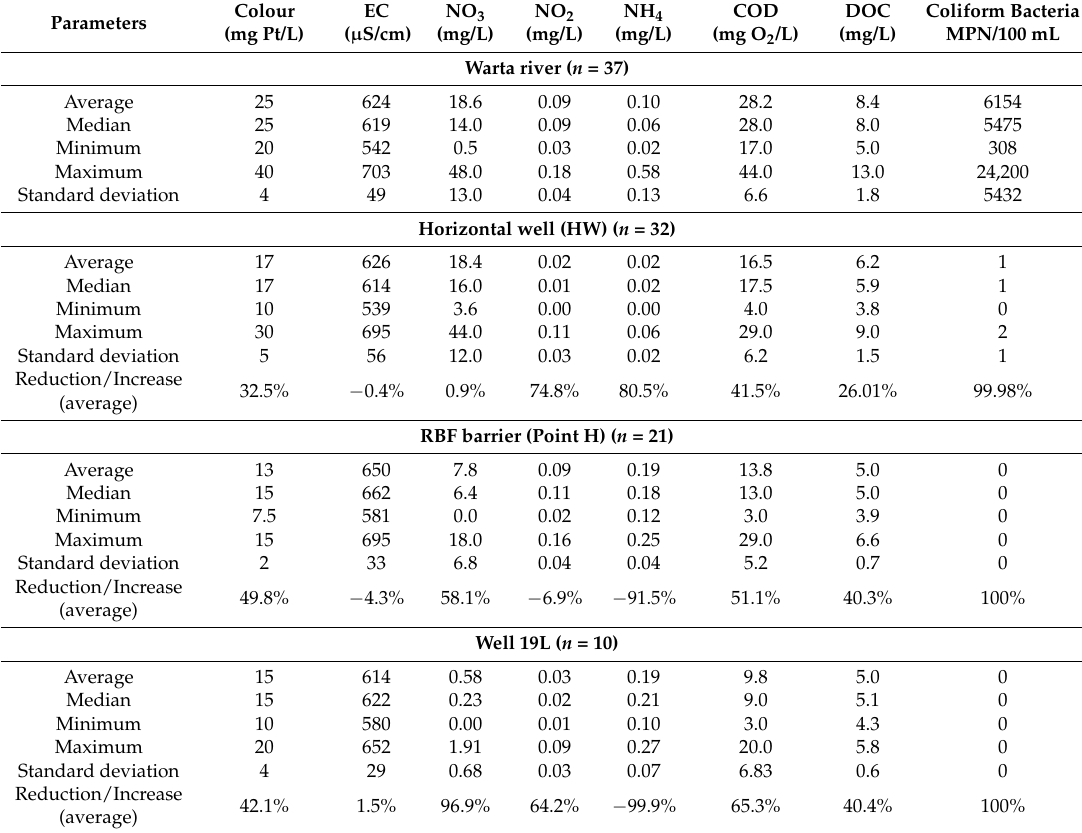
Table 1. Statistical characteristics of the data